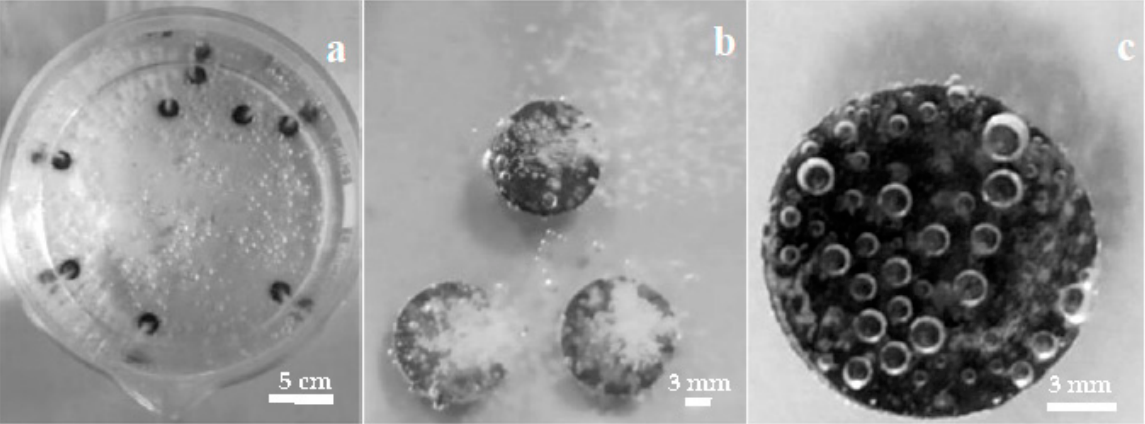
Figure 1. Mg disks immersed in solution during carbonate coating: top views of ( a ) beaker with several Mg disks. ( b ) higher detail image, showing the gas column emanating from each disk, ( c ) one disk after 1 h immersion.